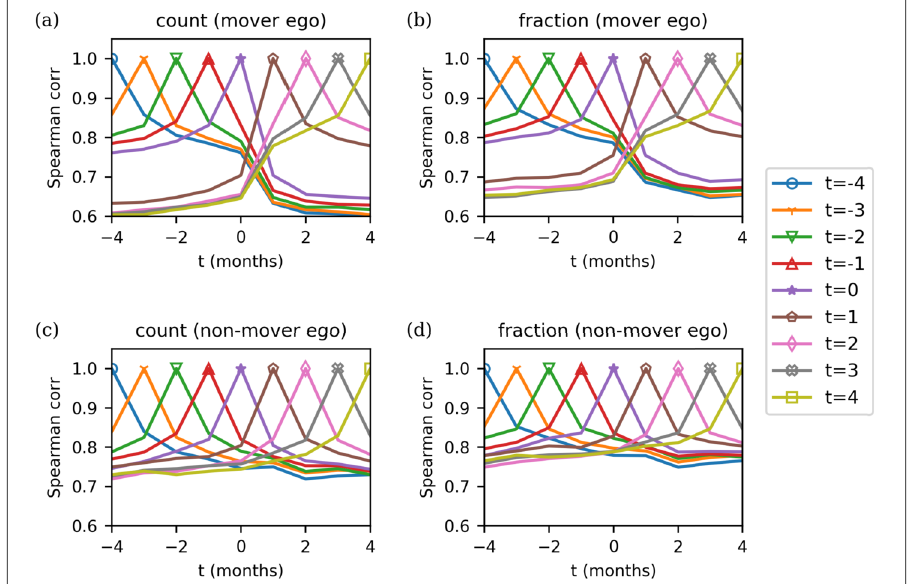
Figure 4 Spearman correlation coefficients for calling frequency quantities between different months. These plots show the Spearman correlation coefficients between the unstandardised number or fraction of calls in one month and another month for pairs with mover egos (( a ) and ( b )) and pairs with non-mover egos (( c ) and ( d )). Each line corresponds to a particular month, and shows the correlation coefficients between that month and all values of t . The correlation coefficient between the particular month and itself simply has a value of